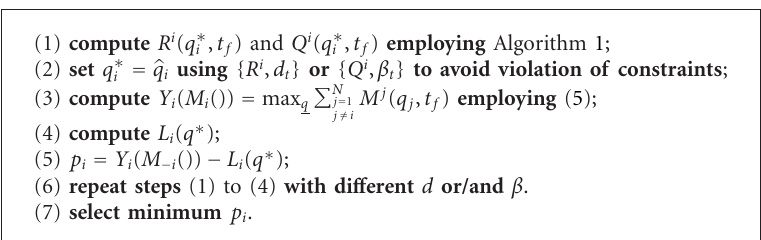
Algorithm 2: Algorithm for q ∗ i and p i